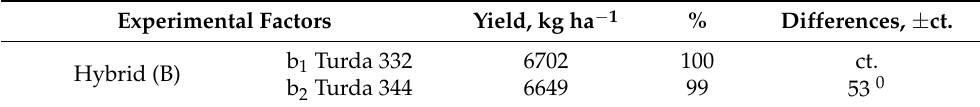
Table 6. Influence of the hybrid on maize average yield, 2016–2021. Experimental Factors Yield, kg ha − 1 % Differences, ± ct.